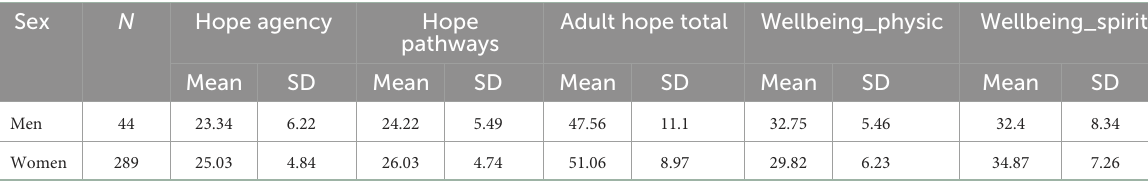
TABLE 2 Descriptive statistics for variables hope and wellbeing related to gender.